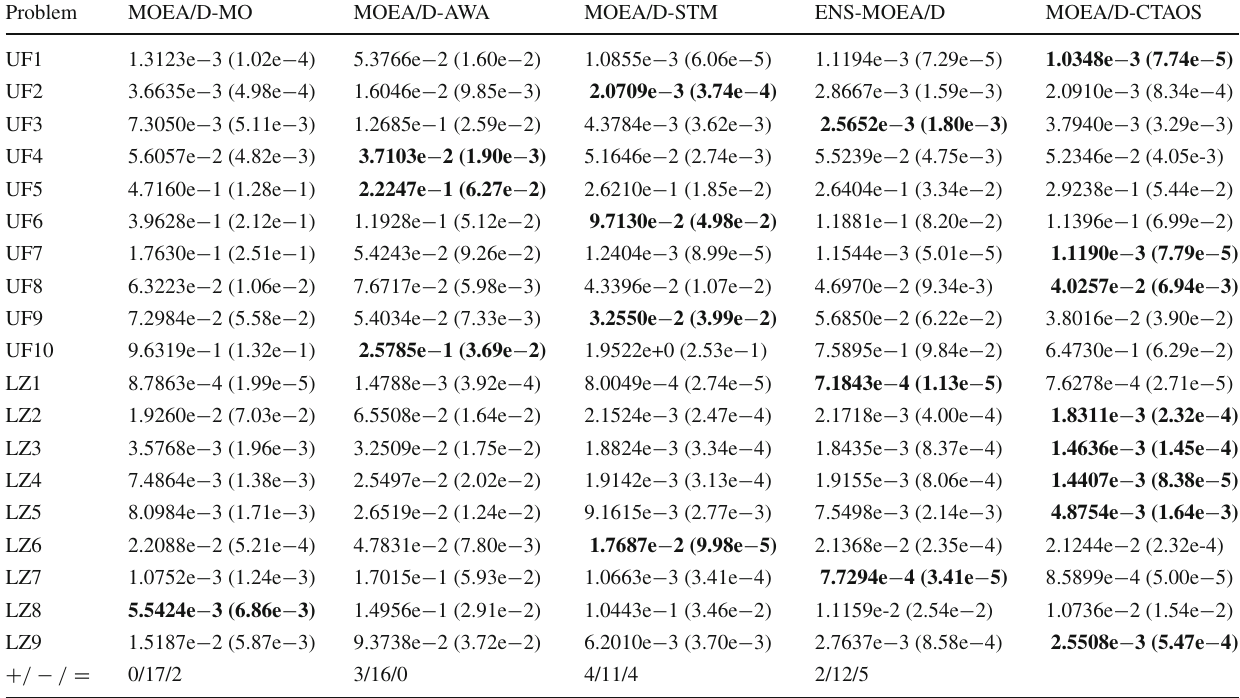
Table 1 Average and standard deviation IGD values obtained by MOEA/D variants on each benchmark (30 runs)